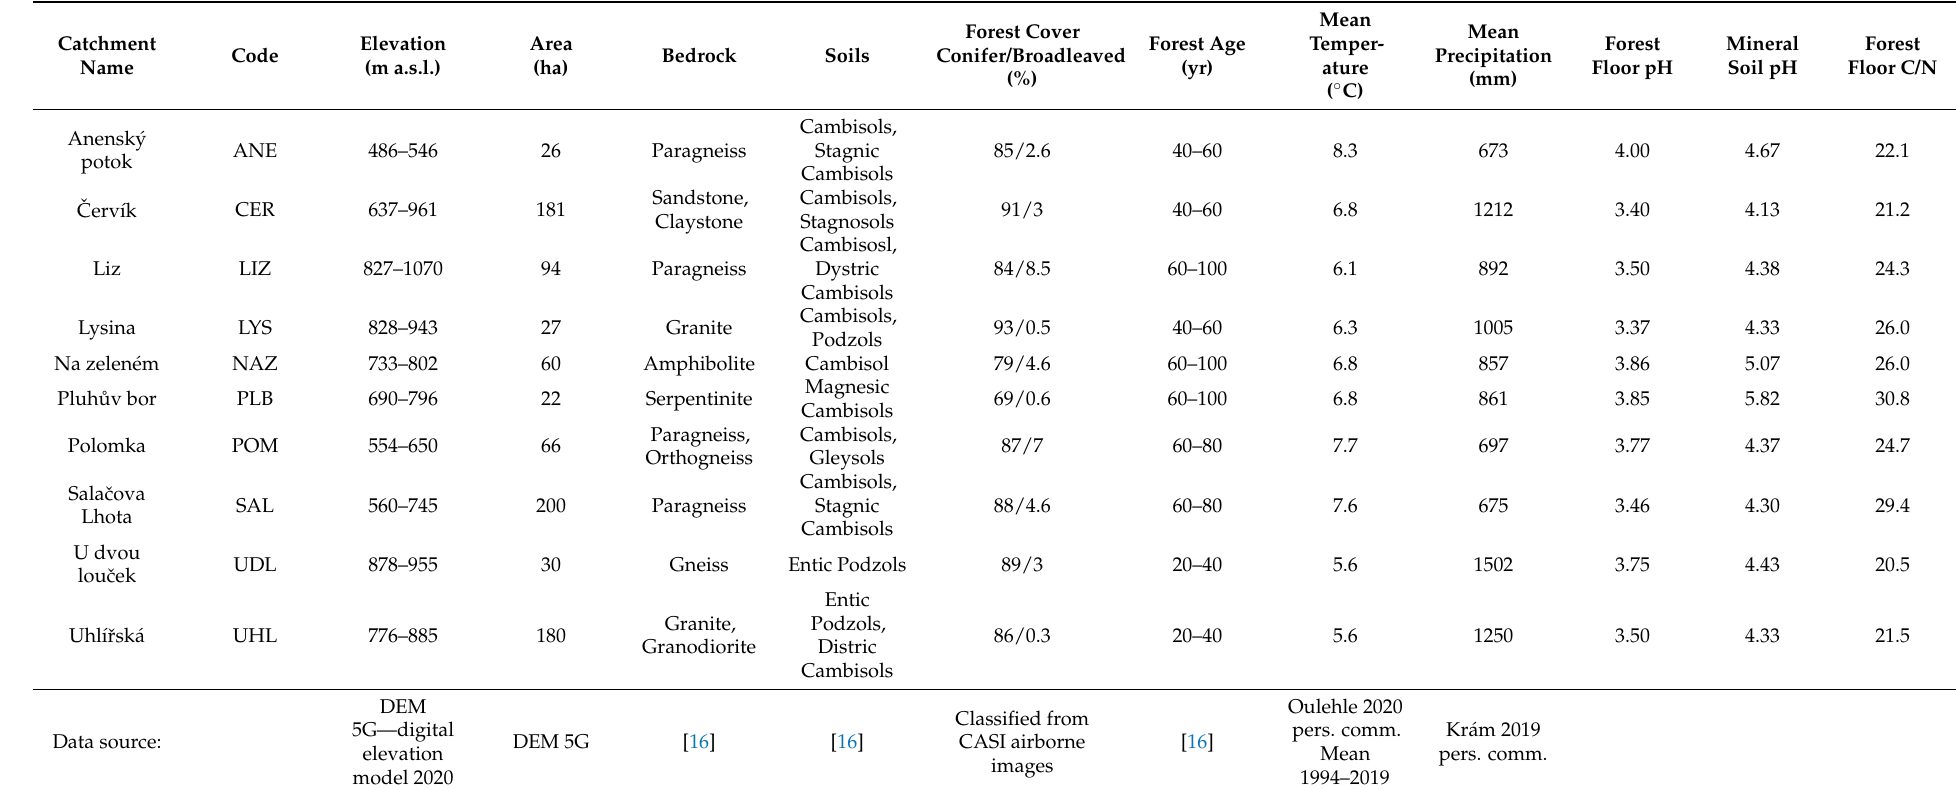
Table 1. Characteristics of ten GEOMON headwater catchments in the present